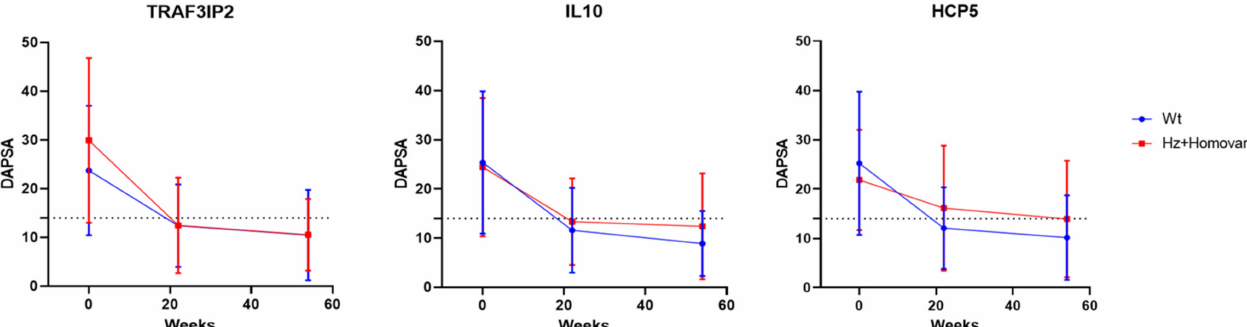
Figure 1. Mean differences of DAPsA values in the genotypic classes for TRAF3IP2 , IL10 and HCP5 SNPs. DAPsA = Disease Activity Index for PsA; Wt = wild-type genotype; Hz = heterozygous geno- type; Homo var = homozygous genotype. The dotted line indicates 15 DAPsA value corresponding to low disease